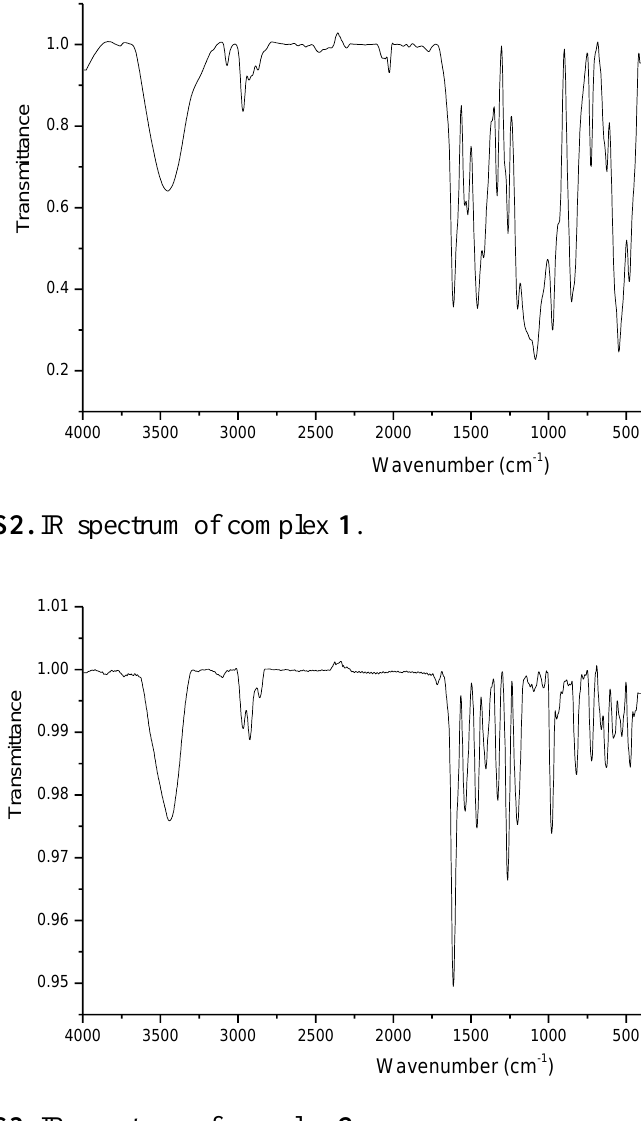
Fig. S3. IR spectrum of complex 2 .